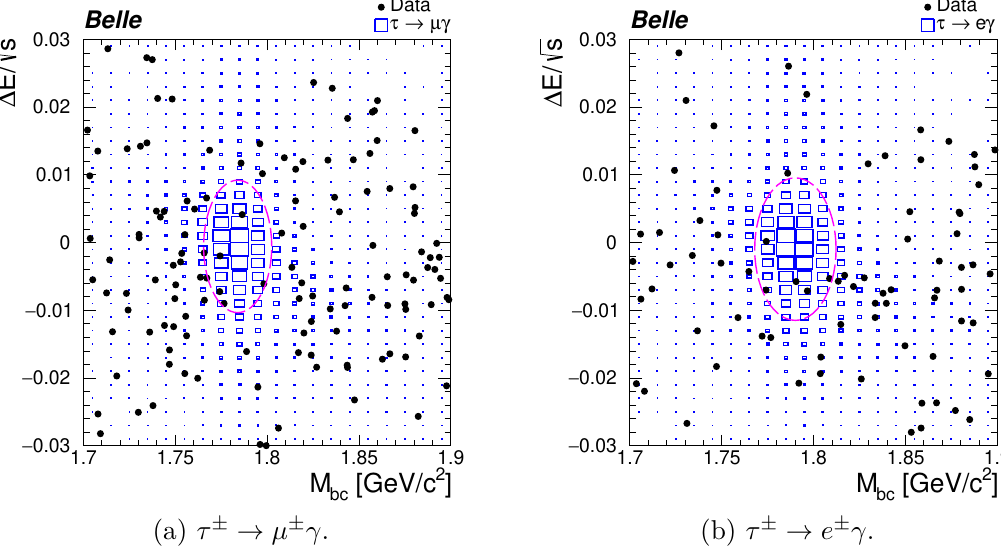
√ Figure 4 . Two-dimensional distributions of ∆ E/ s vs. M bc for (a) τ ± → µ ± γ and (b) τ ± → e ± γ events. Black points are data, blue squares are τ ± → ‘ ± γ signal MC events, and magenta ellipses show the signal region used in this analysis ( ± 2 σ